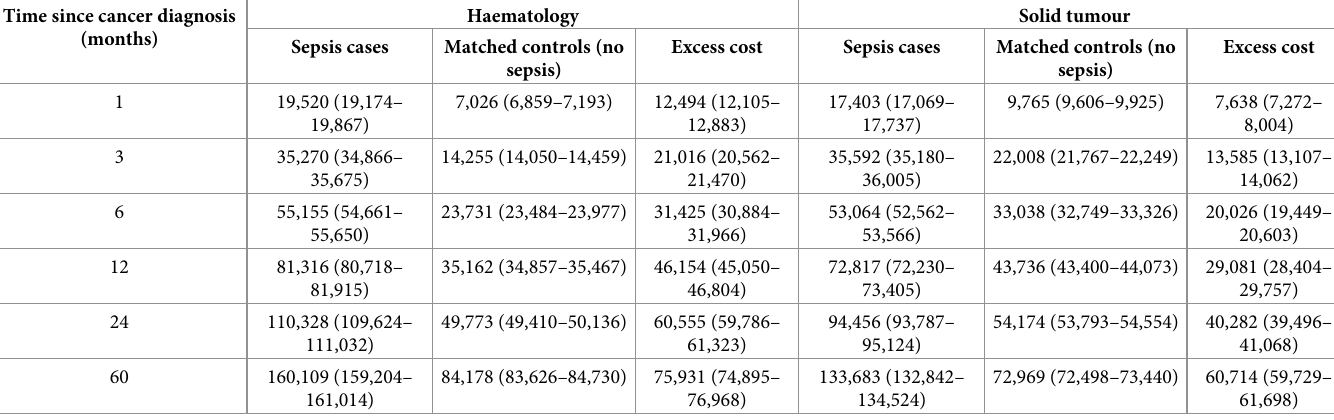
Table 2. Cumulative cost of care ($CAD 2018, 95% CI) between sepsis cases and matched controls. Time since cancer diagnosis